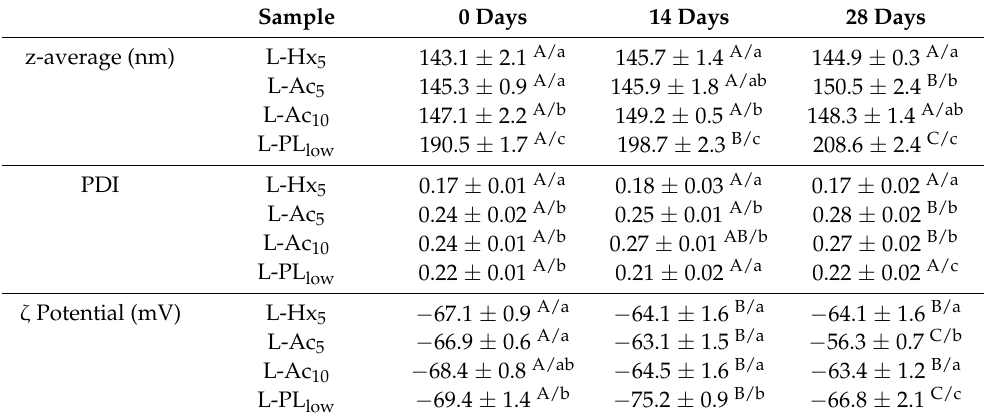
Table 1. Z-average, polydispersity index (PDI) and ζ potential of